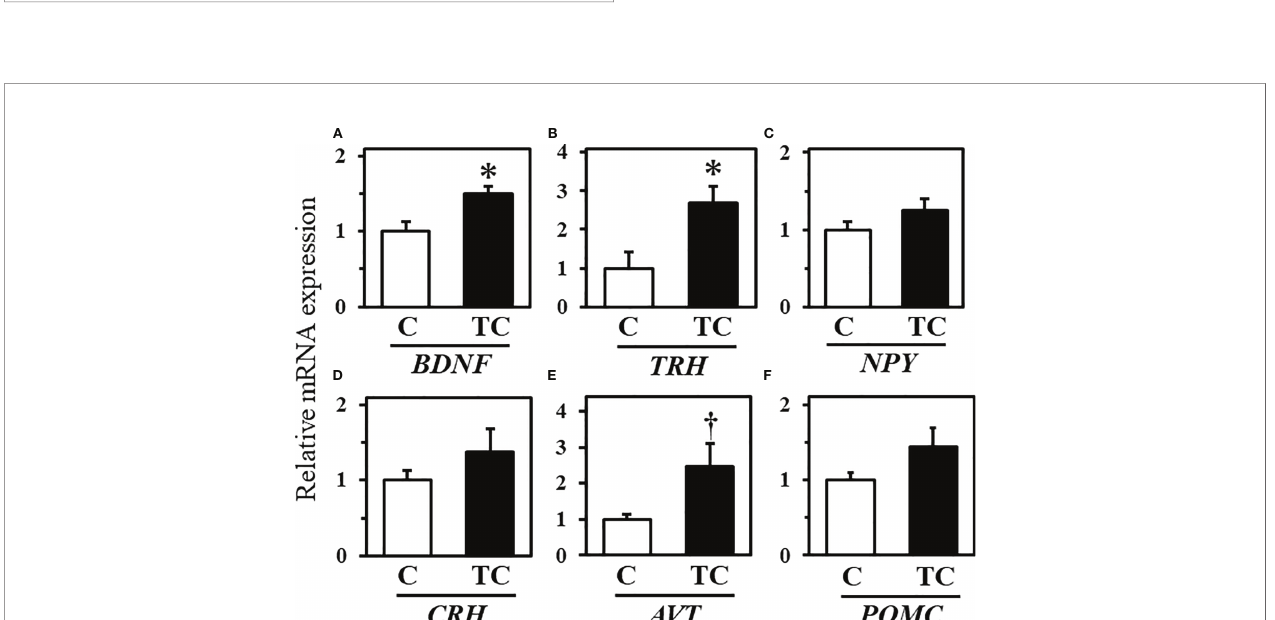
FIGURE 3 | Plasmametaboliteconcentrationsafter lowtemperatureexposurein experiment 2(mean±SEM). (A) showsplasmaglucoseconcentrations, (B) shows plasmafreefattyacid(FFA) concentrations and (C) showsplasmacorticosterone concentrations. Thenumber ofchicksineachgroupwasn=8. C, control;TC, thermalconditioning. † means